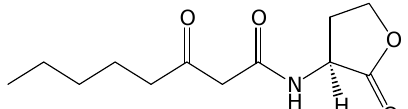
Figure 2: Structure of N -(3-oxooctanoyl)-L- homoserine lactone.